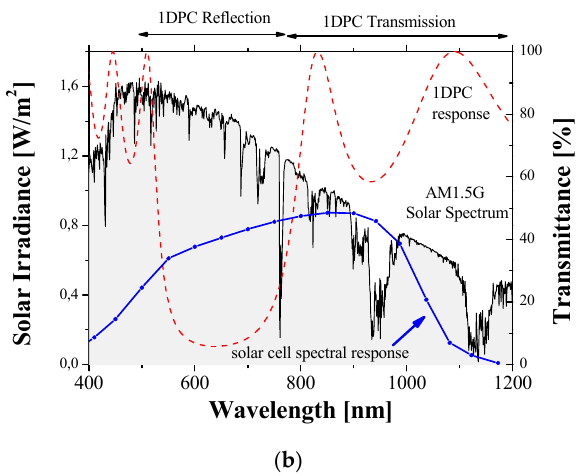
Figure 1. ( a ) One-dimensional photonic crystal (1DPC) designed to minimize solar cell overheating by reflecting nonabsorbed infrared photons. ( b ) 1DPC designed to act as back spectral selective mirror or beam splitter: Visible solar spectrum is reflected. Dashed red line: photonic crystal transmittance; blue dots: silicon solar cell spectral response.